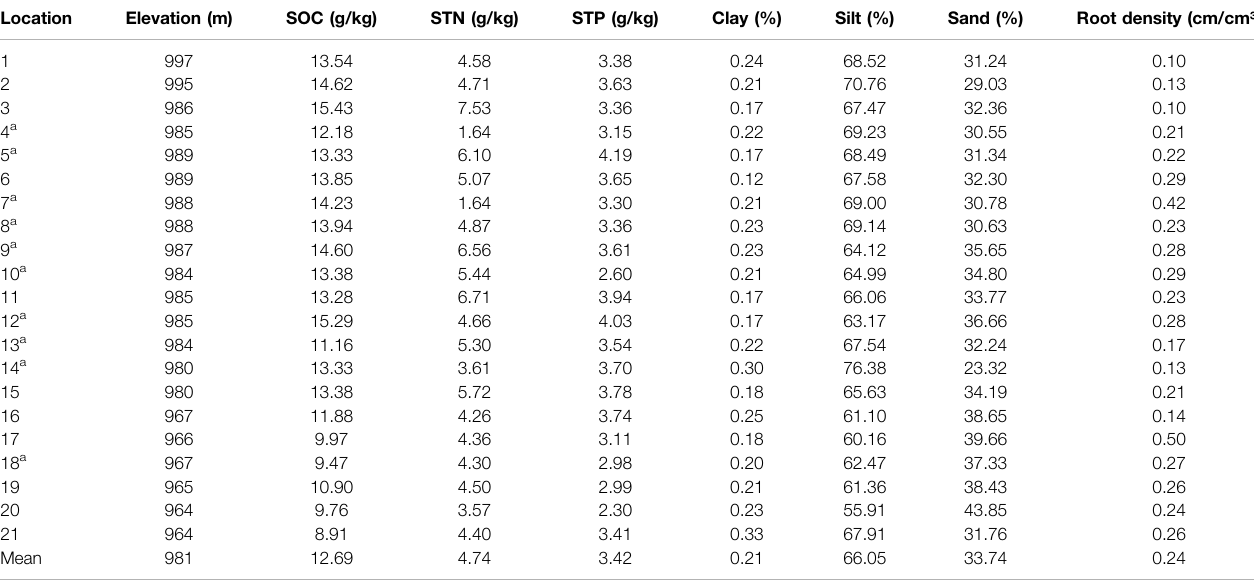
TABLE 3 | The soil characteristics of the representative locations and the whole study area.